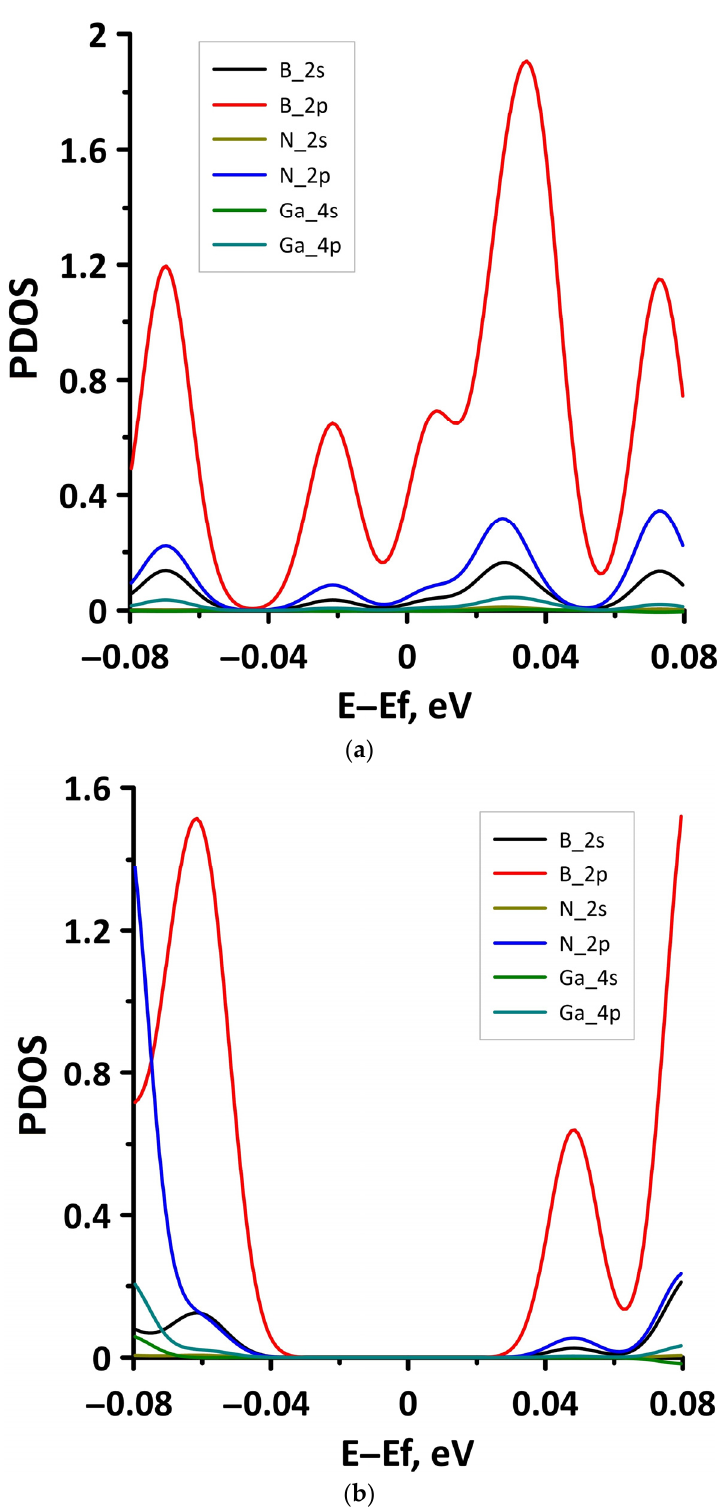
Figure 8. Fragments of PDOS near the Fermi level (shifted to 0 eV) of borophene/GaN heterostruc- ture under uniaxial compression by 1% ( a ) and 14% ( b ). under uniaxial compression by 1% ( a ) and 14% ( b